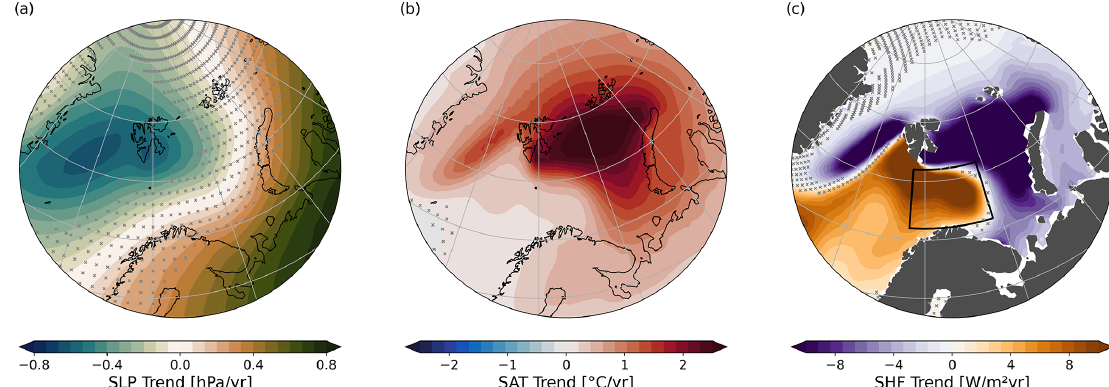
Figure 5. Linear trend of (a) sea level pressure (SLP), (b) surface air temperature (SAT), and (c) surface heat flux (SHF) anomalies during ice loss events, averaged over all events. Ocean heat loss is defined as negative, meaning that positive (negative) anomalies refer to less (more) heat loss. The black box indicates the area for averaging SHF to assess its influence on RICEs. Crosses indicate areas where the trend is not statistically significant at the 95% confidence